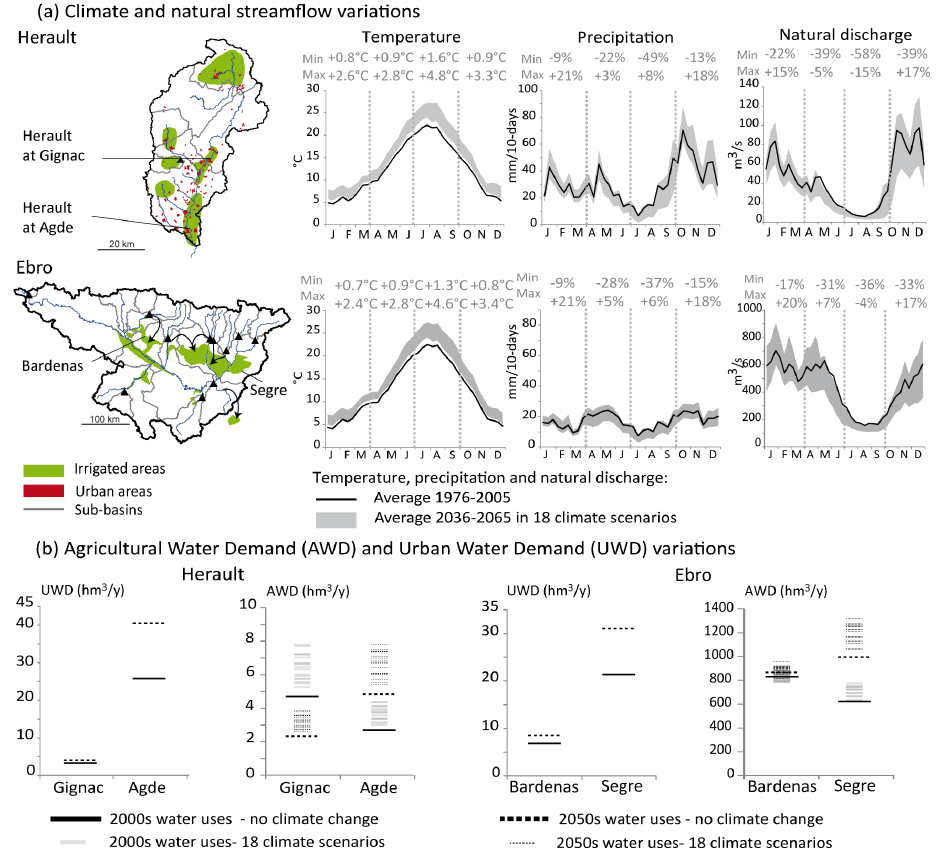
Figure 3. Projected hydro-climatic and water demand changes at the 2050 horizon at the scale of the Herault and the Ebro catchments: (a) range of 18 climatic scenarios and their potential impact on natural streamflow at the outlet and (b) variations in urban and agricultural water demand in illustrative sub-basins under combined water use and climate scenarios.